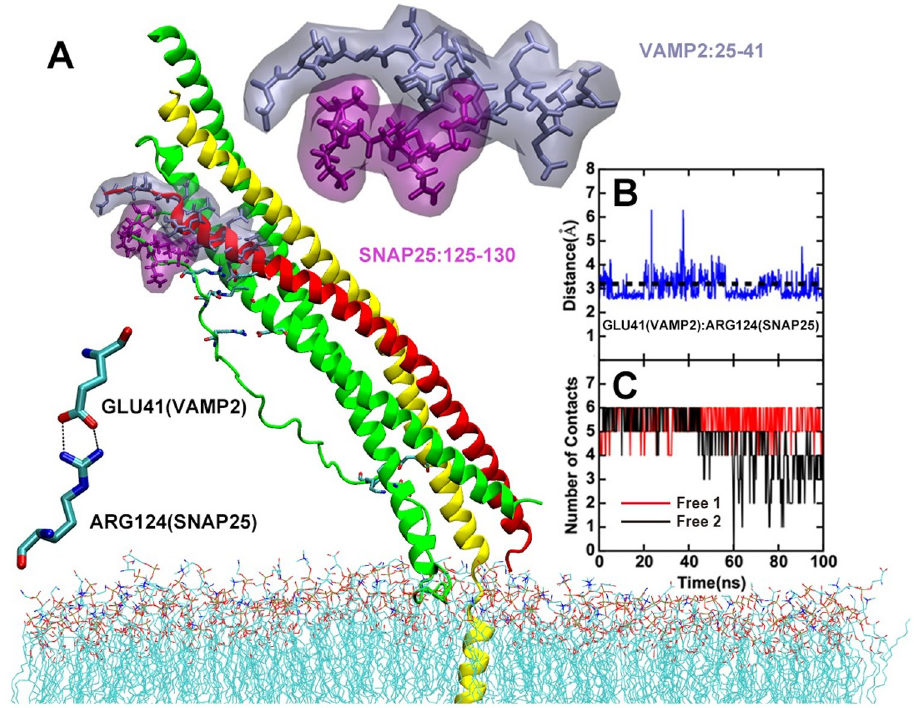
Fig 3. LL region of SNAP25 forms interactions with VAMP2. (A)snapshot of the free MD simulation. The interactions on the N-terminal residuesof NTD regionare highlighted,with VAMP2 residues 25 to 41 shown in gray and SNAP25 residues125–130shown in purple. A specific salt bridgebetweenVAMP2 E41 and SNAP25 R124 is also indicated. (B)The time-courseof the distanceVAMP2 E41 and SNAP25 R124 for Free2, a distance below3.2 Å can be viewedas salt bridge fromed. (C)Number of contacts betweenof SNAP25 with VAMP2 residues 24 to 41.